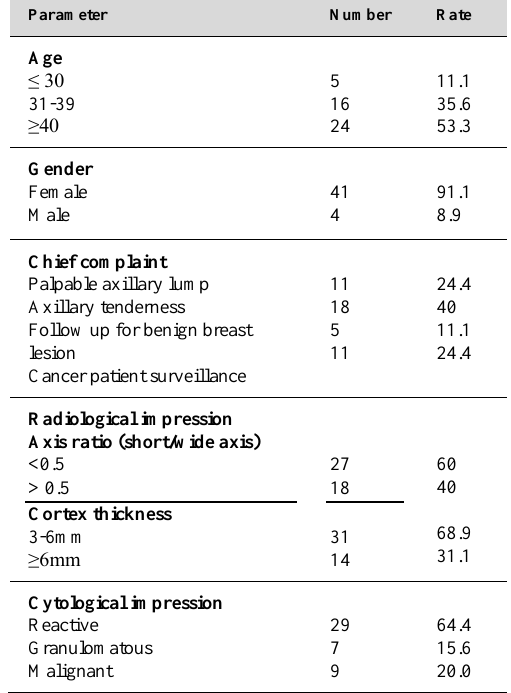
Table 1 Demographic characteristics and diagnostic impression of